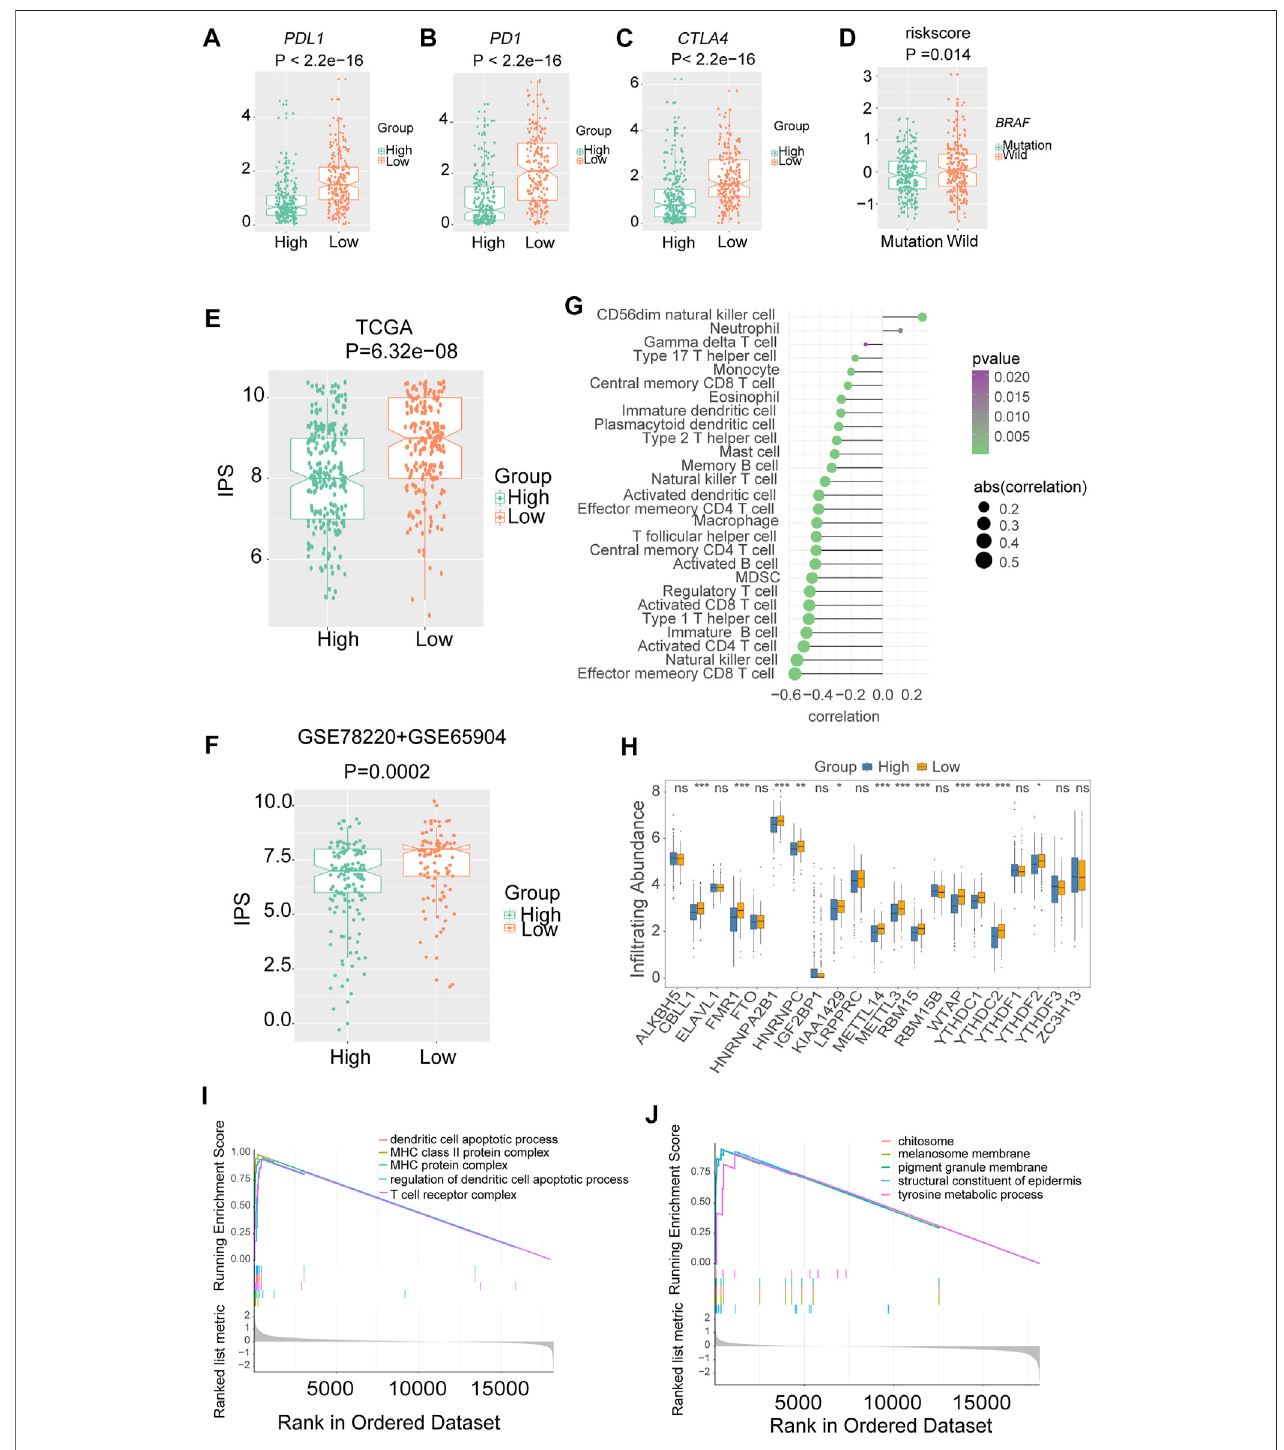
FIGURE 7 | The association between risk signature and immune in fi ltration in melanoma. The expression of three immune checkpoints in TCGA melanoma with different risk groups (A) PDL1 . (B) PD1 . (C) CTLA4 . (D) The level of risk scores in TCGA melanoma with different mutation statuses of BRAF . The immunophenoscores (IPS) in TCGA and combined gene expression omnibus (GEO) cohorts, (E) TCGA. (F) Combined-GEO cohorts. (G) The correlation between risk scores and immune in fi ltration cells in TCGA melanoma. (H) Box plots were used to visualize the differential expression of 21 m6A regulators in high- and low-risk groups (* p < 0.05, ** p < 0.01, *** p < 0.001). (I) Gene ontology (GO) analysis showed that the low-risk group was enriched in pathways associated with immune full activation; (J) the high- risk group was prominently enriched in Melanin metabolism pathways.